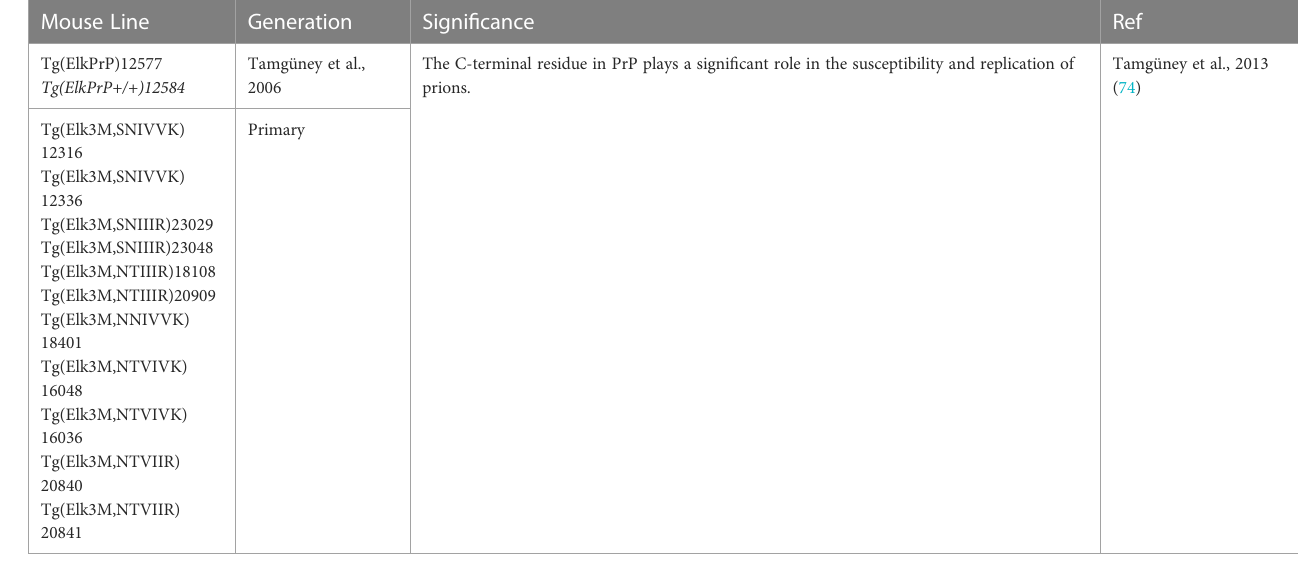
TABLE 6 Transmission concerning structure. Mouse